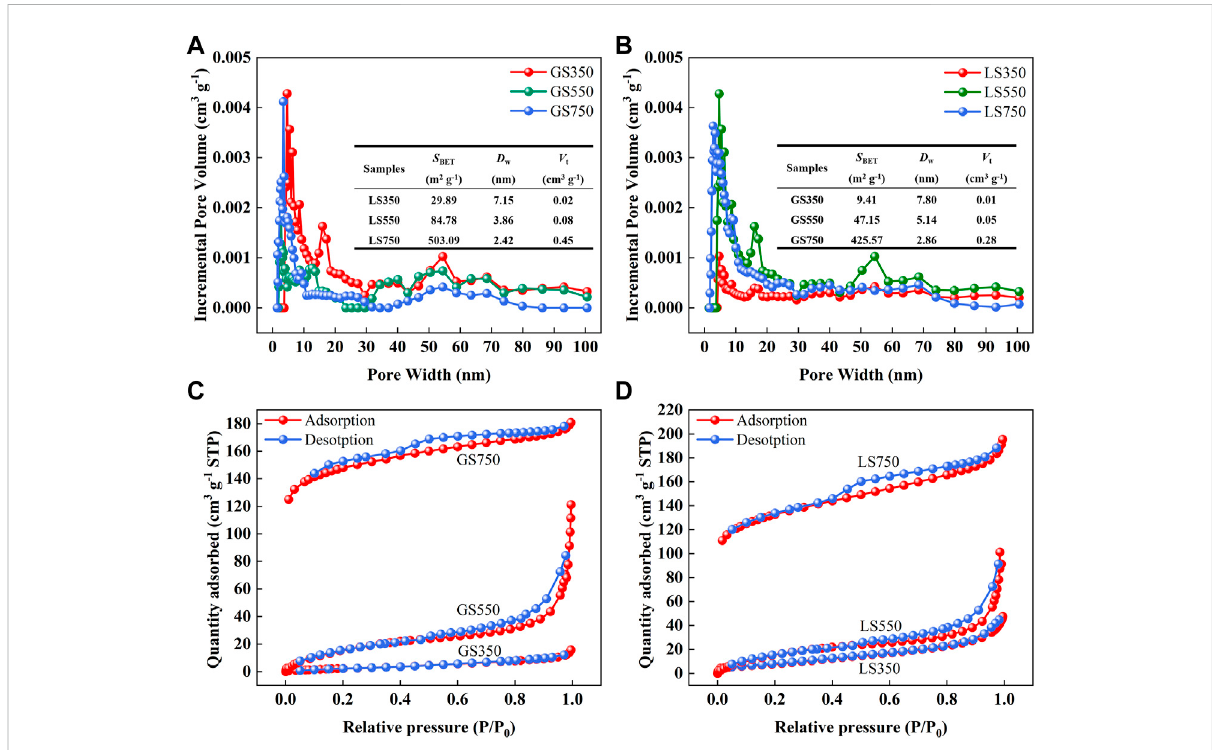
The pore-sizedistributioncurves of GSBC (A) and LSBC (B) , and N 2 adsorption-desorption isotherm ofGSBC (C) and LSBC (D) . Insets in (A) and (B) are the data of speci fi c surface area ( S BET ), average pore diameter ( D w ), and total pore volume ( V t ) of